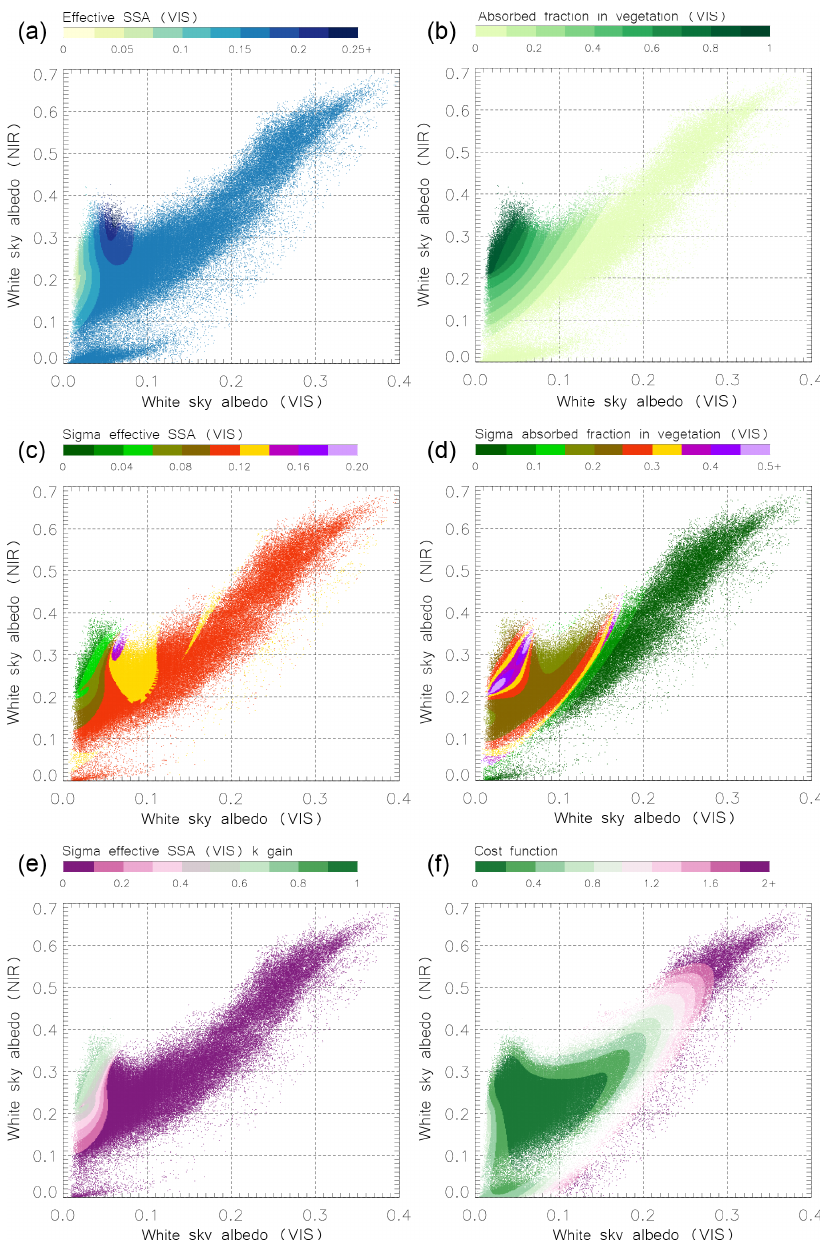
Figure 5. Mean value (upper panel), uncertainty (middle panel) of effective canopy single scattering albedo (left), and FAPAR (right). Uncertainty reduction (denoted here as k gain for knowledge gain) of effective canopy single scattering albedo (bottom left) and misfit function (see Eq. 4) at minimum (bottom